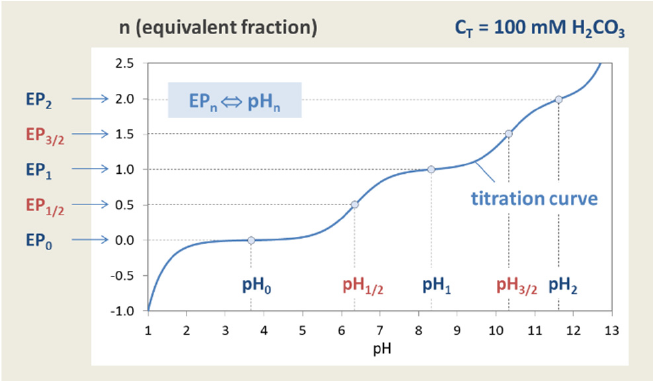
Figure 15. Relationship EP n ⇔ pH n . EPs and semi-EPs are located at integer and half-integer values of n on the titration curve. Calculation for 100 mM H 2 CO 3 .